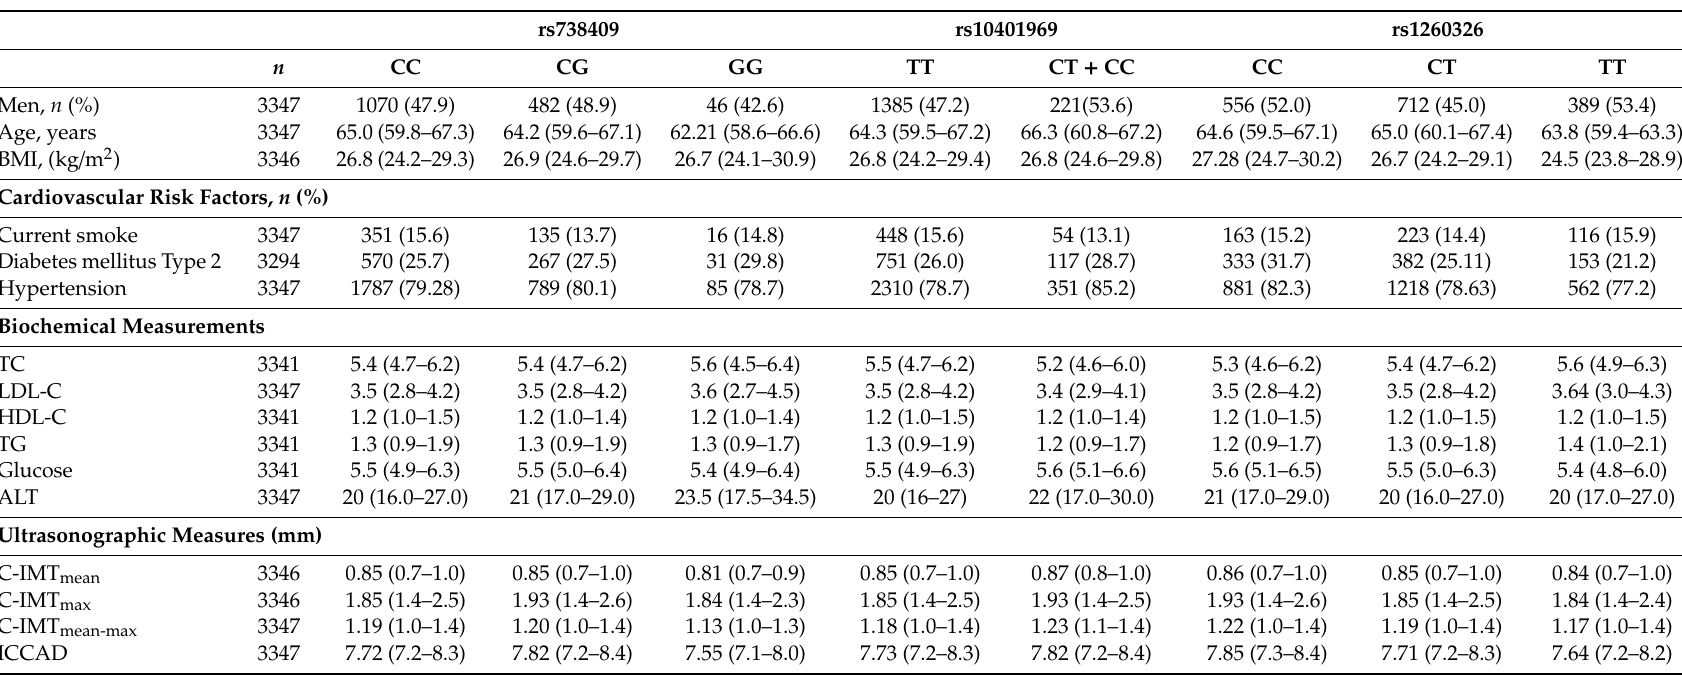
Table 1. Clinical characteristics, and biochemical and ultrasonographic measurements in the IMPROVE study population stratified by rs738409 (C / G), rs10401969 (T / C), and rs1260326 (C / T). Data are expressed as median (interquartile ranges) for continuous variables or number (percent) for categorical